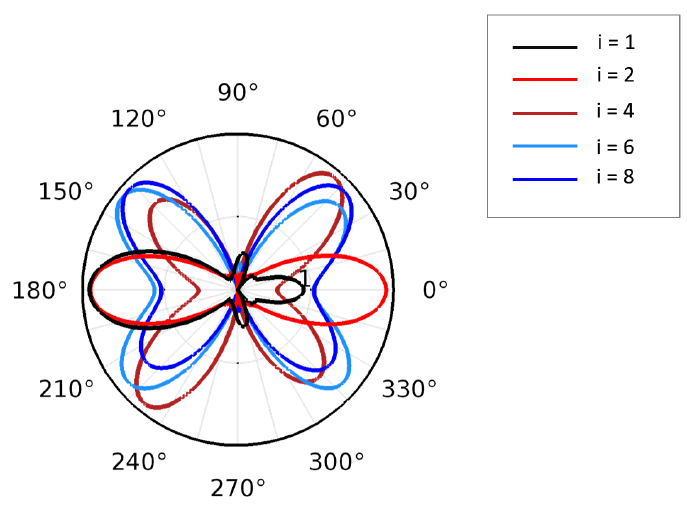
Figure A2. The fundamental wavelength (FW) radiation pattern for the optimized plane wave excitations considered in the body of the article.